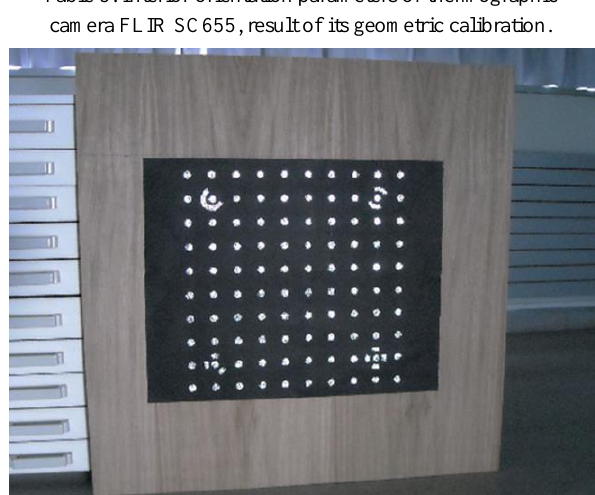
Figure2: Calibration grid for the geometric calibration of thermographic cameras.